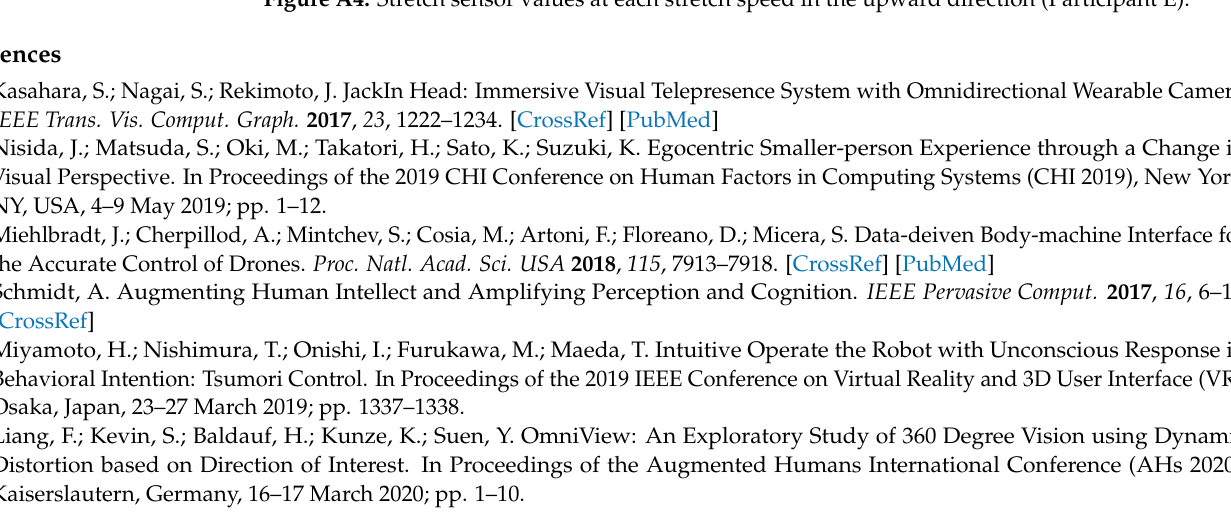
Figure A4. Stretch sensor values at each stretch speed in the upward direction (Participant